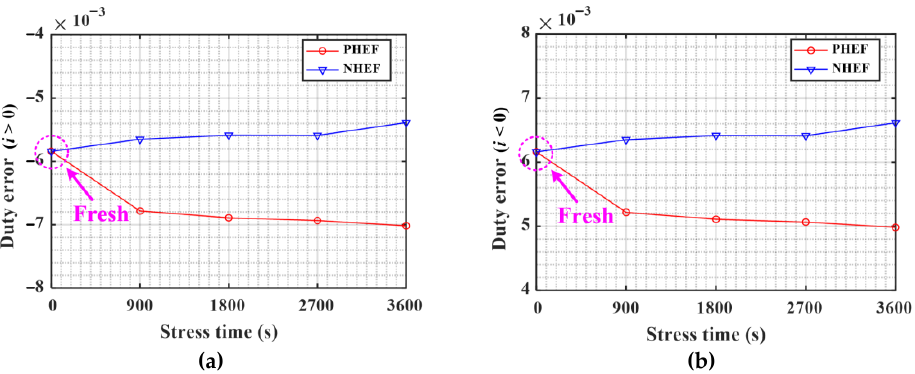
Figure 27. Duty error according to stress time ( a ) i > 0, and ( b ) i < 0.